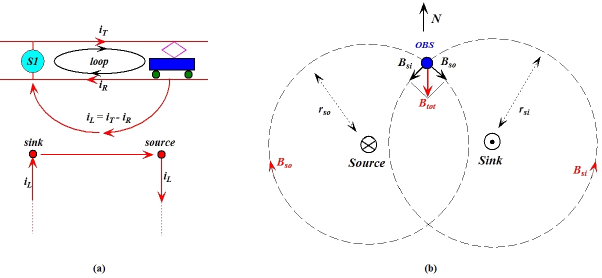
Figure 9. (a) A schematic diagram of the railway current distribu- tion powered by one substation. (b) A schematic representation of the composition of two magnetic fields generated at the source and sink